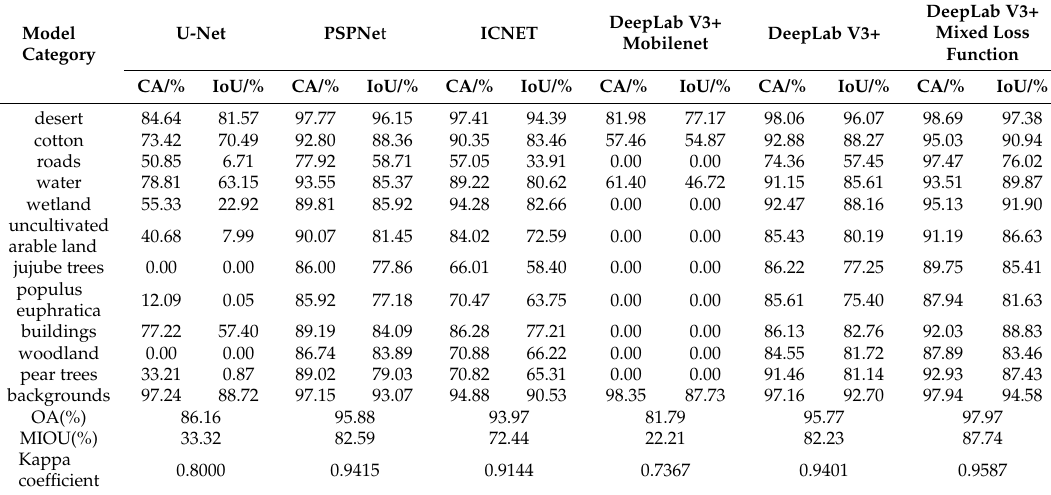
Table 5. Experiment results of models with different structure on test